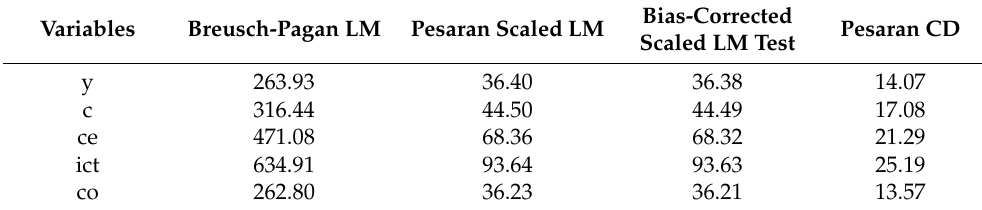
Table 4. Cross-sectional dependence tests.